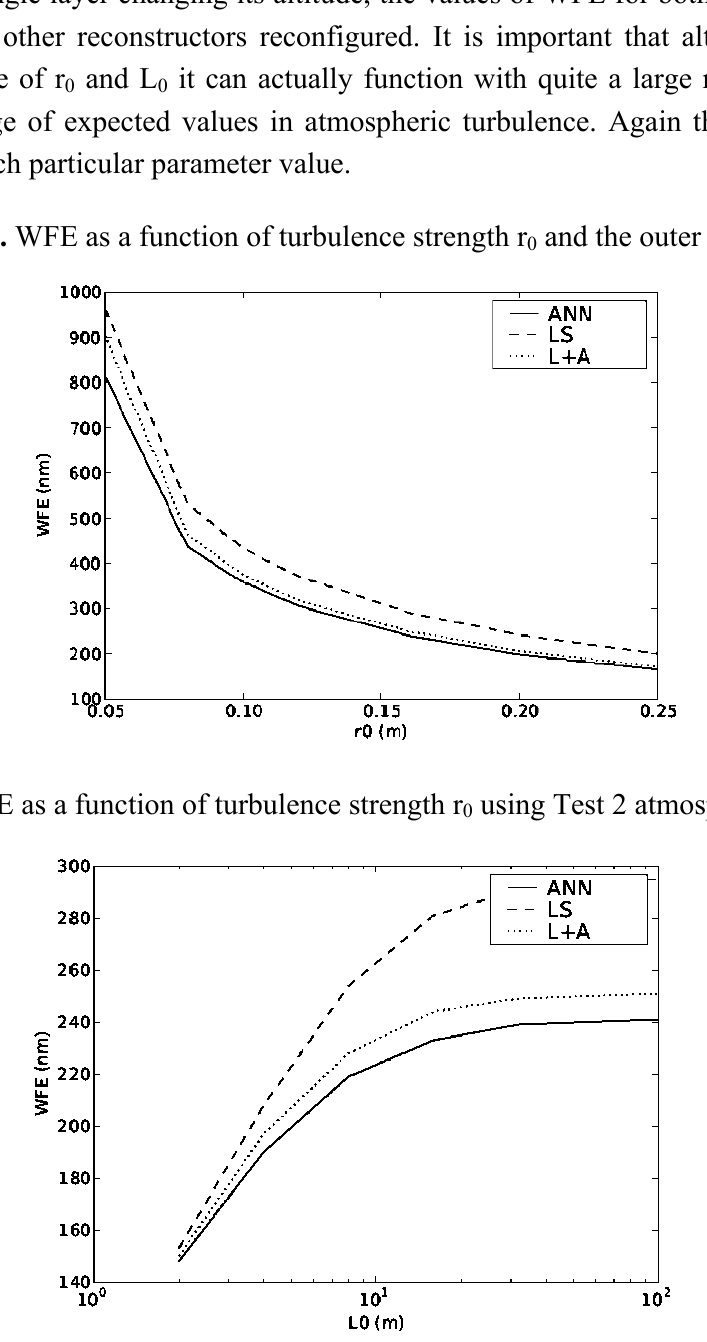
Figure 4. WFE as a function of turbulence strength r